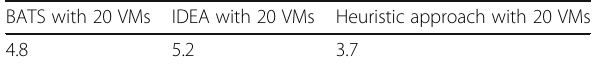
Table 18 Comparison of the proposed heuristic approach with the BATS and IDEA frameworks in term of RT in